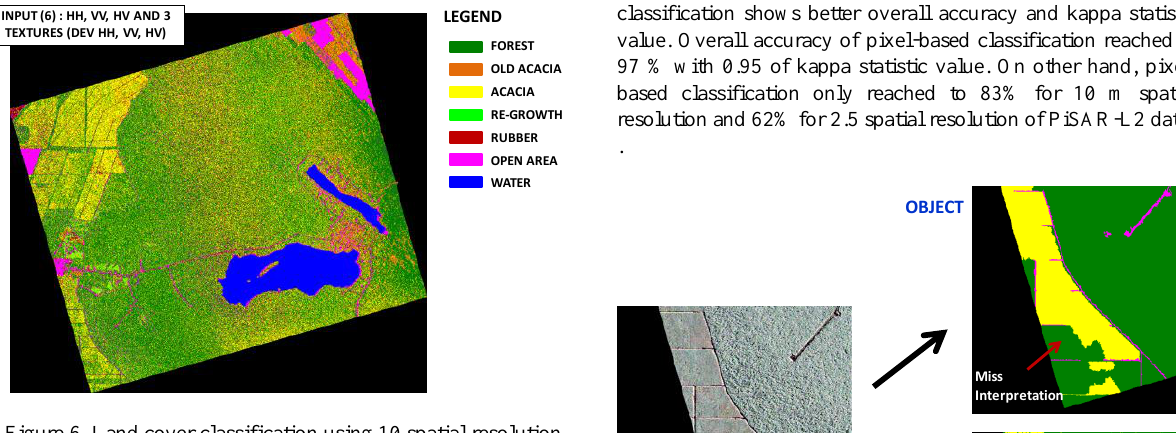
Figure 6. Land cover classification using 10 spatial resolution with 3 polarization bands and 3 texture bands